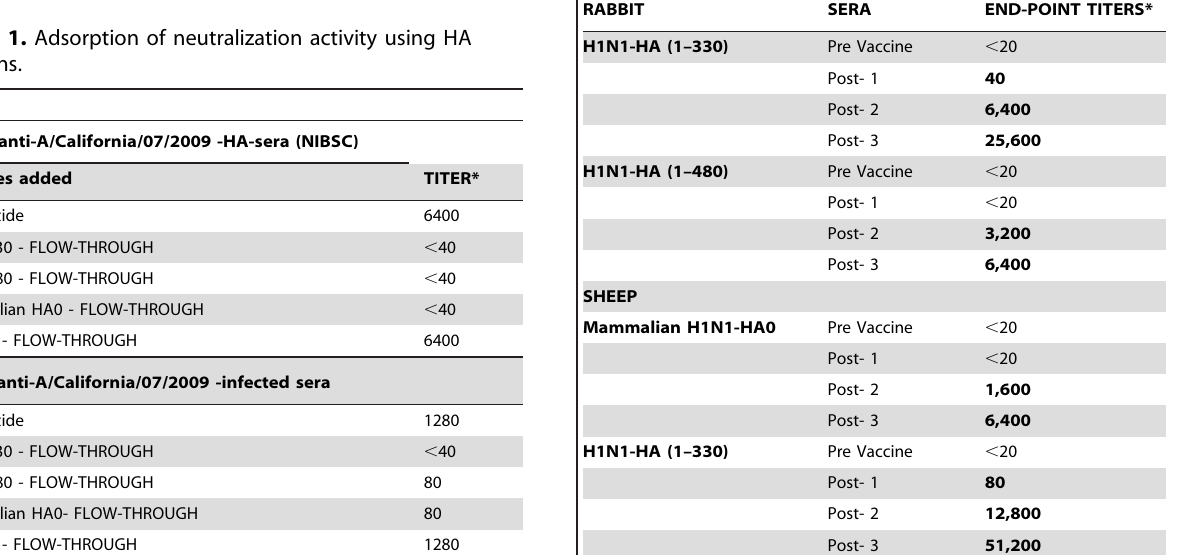
Figure 2. Development of neutralizing and anti-HA binding antibodies following wt H1N1 (A/California/7/2009) infection in ferrets & post-H1N1 vaccination (inactivated vaccine) in humans. (A) Microneutralization of H1N1 A/California/2009 virus with post-H1N1- infected ferret samples. End-point titers (mean of three replicates) using post-infection sera from multiple ferrets at each time point in a microneutralization assay performed with A/California/07/2009 (X-179A). For day 21, sera of ten animals were pooled. Each dot in other time-points represents an individual H1N1 infected ferret. (B–D) Antibody kinetics following H1N1 challenge in ferrets. Steady-state equilibrium analysis of post-H1N1 infected ferret sera or pre- & post-H1N1 vaccinated human sera to mammalian H1N1 HA0 (Immune Technologies, NY) and properly folded bacterially expressed H1N1 HA1 (1–330) or H1N1 HA (1–480) fragment were measured using SPR. Ten-fold diluted individual post-infection sera from each time point, were injected simultaneously onto recombinant mammalian H1N1 HA0 in (B) and properly folded bacterially expressed H1N1 HA1 (1–330) in (C) or H1N1 HA (1–480) in (D), immobilized on a sensor chip through the free amine group, and onto a blank flow cell, free of peptide. SPR binding of pre-vaccine and post-H1N1 vaccination sera from two individuals with different neutralizing antibody titers (in parenthesis) is shown with recombinant mammalian H1N1 HA0 in (E) and properly folded bacterially expressed H1N1 HA1 (1–330) in (F) or H1N1 HA (1–480) in (G). Binding was recorded using ProteOn system surface plasmon resonance biosensor instrument (BioRad Labs, Hercules, CA).